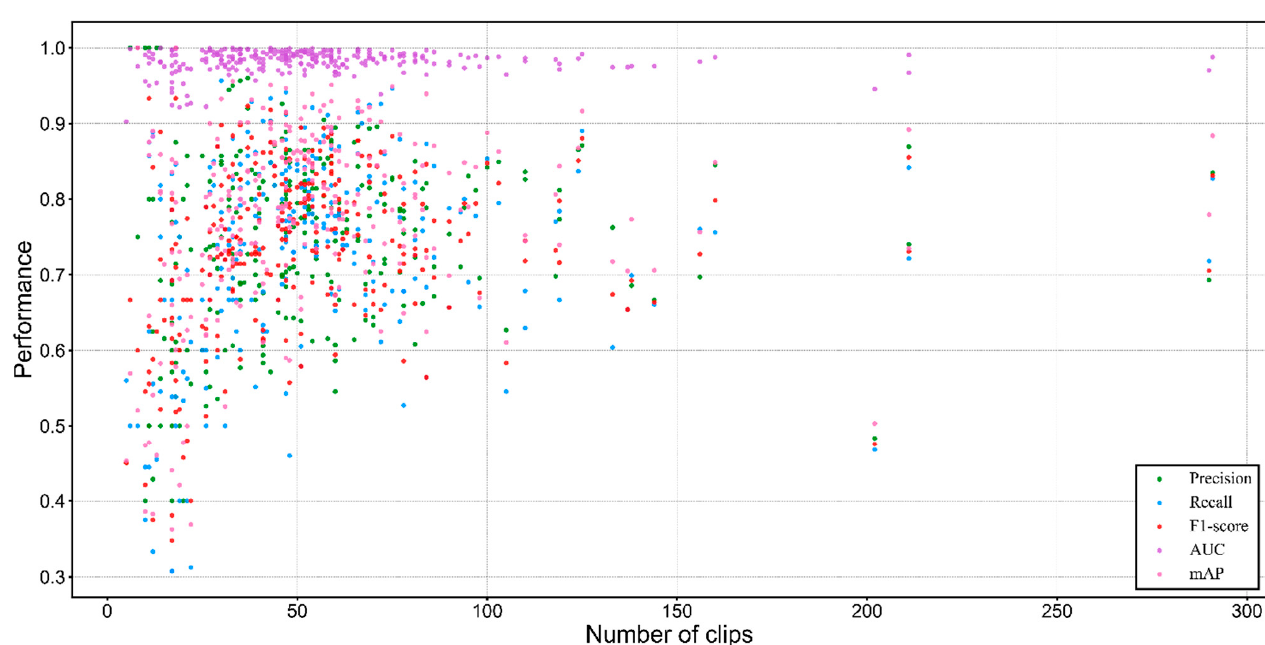
Figure 9. Boxplots of the proposed model. Each metric includes 264 results. Statistics: Pre max = 100.00%, Pre min = 40.02%, Pre std = 0.1170, Pre avg = 74.51%; Rec max = 100.00%, Rec min = 30.76%, Rec std = 0.1268, Rec avg = 73.51%; F1 max =100.00%, F1 min = 34.78%, F1 std = 0.1090, F1 avg = 73.45%; AUC max = 100.00%, AUC min = 88.29%, AUC std = 0.0163, AUC avg = 98.21%; mAP max = 100.00%, mAP min = 36.25%, mAP std = 0.1195, mAP avg = 77.43%.